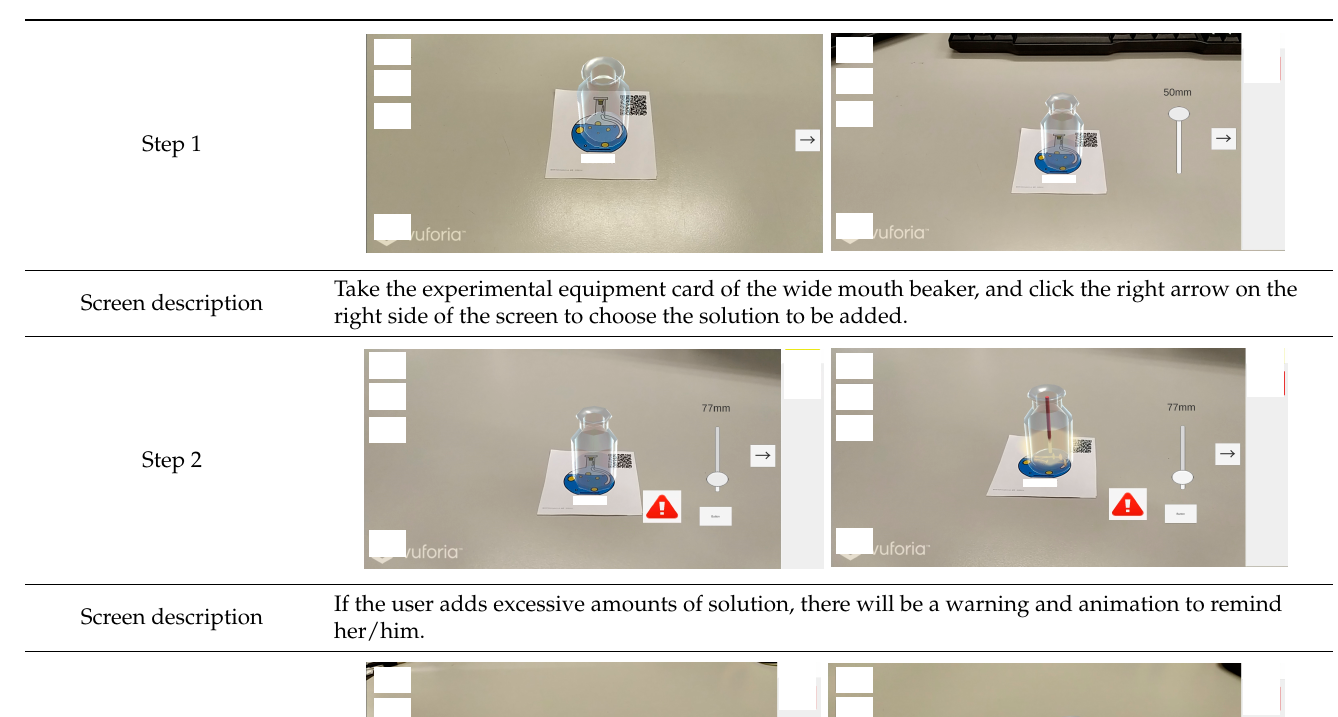
Table 7. Steps of operating the oxygen production experiment.